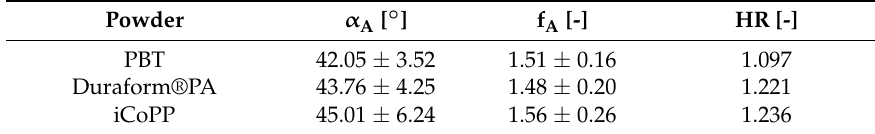
Table 5. Powder flowability results for the PBT powder and commercially used reference powders.